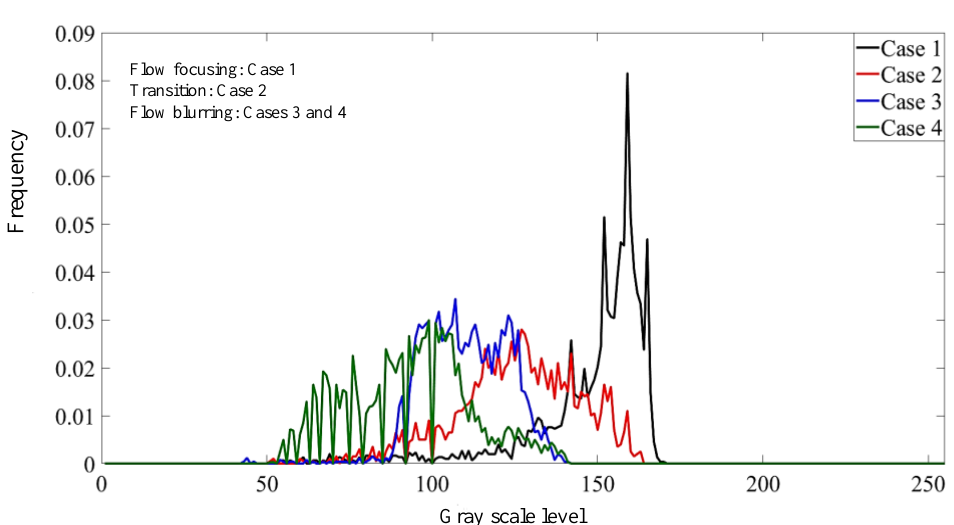
Figure 8. The gray distribution curves of the two-phase flow images under different air flow rates: the water flow rate, tube-hole distance and orifice diameter are 100 mL/min, 1 mm and 5 mm, respectively. For cases 1 to 4, the air flow rates are 10 L/min, 20 L/min, 40 L/min and 60 L/min, respectively.